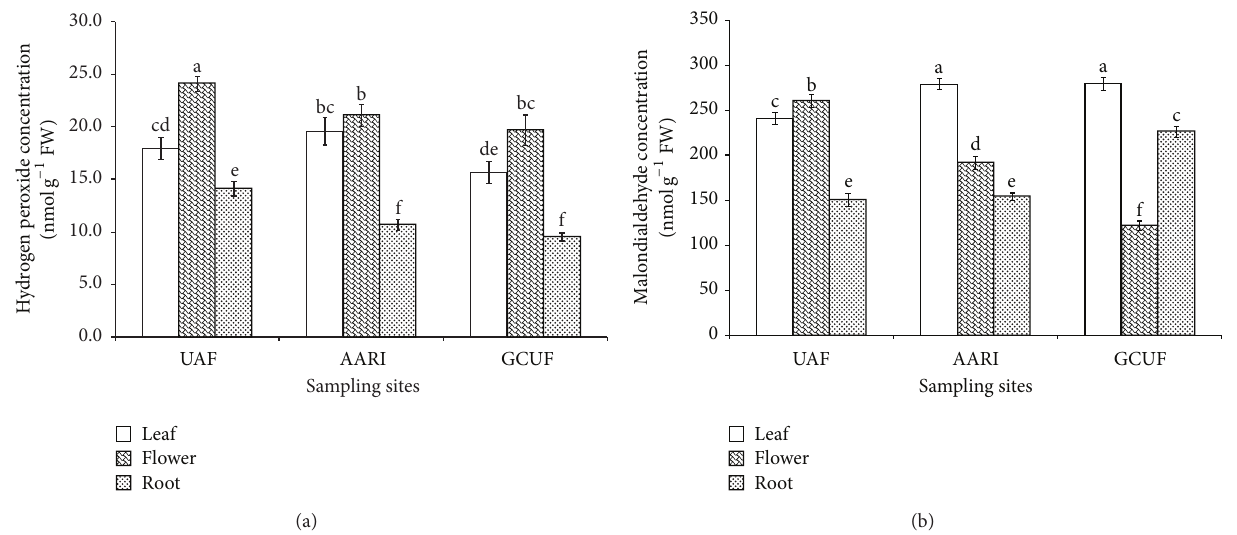
Figure 6: Hydrogen peroxide (H 2 O 2 ) (a) and malondialdehyde (MDA) concentration (b) in different tissues of calendula plants collected from semiarid zone. Values ( 𝑛 = 9 ± SE) with different superscripts (a–f) are significantly different at 𝑃 < 0.05